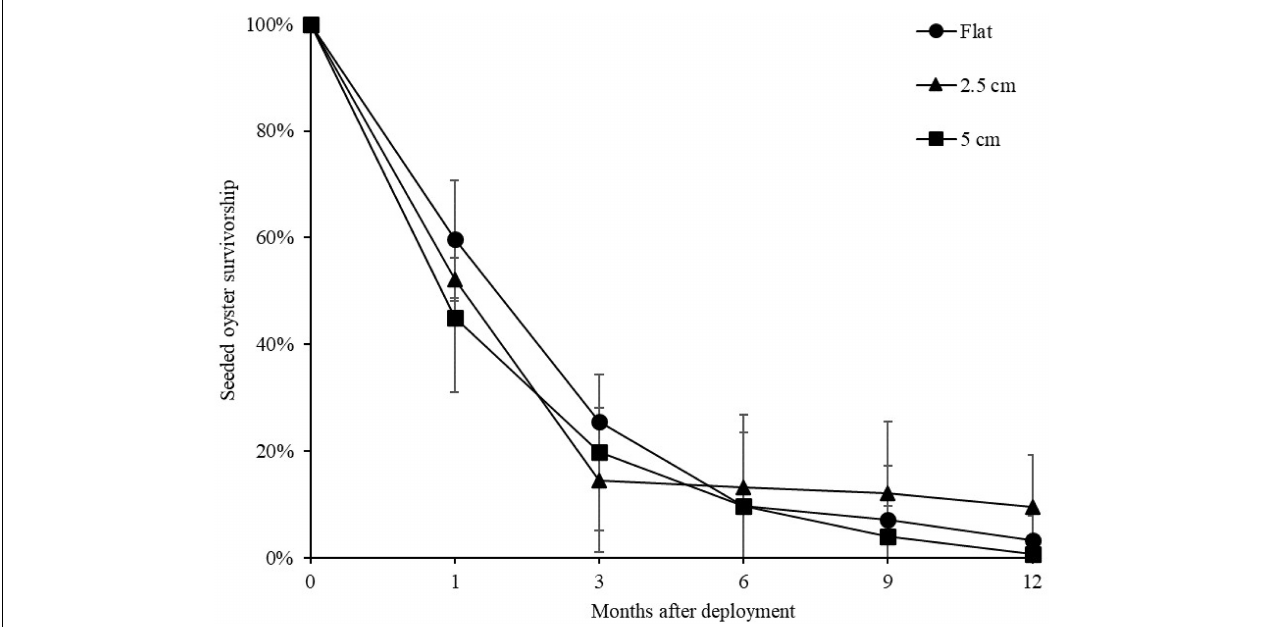
FIGURE 2 | Mean ( ± SE) percentage of seeded oyster survivorship on seeded flat, 2.5 and 5 cm tiles through time, averaged across both sites. Survival at each time point was in relation to the original seeded population. TABLE 1 | Linear mixed effect model testing the effects of physical complexity and time on seeded oyster survivorship withsite as random factor. Source df Mean square Standard error p -value